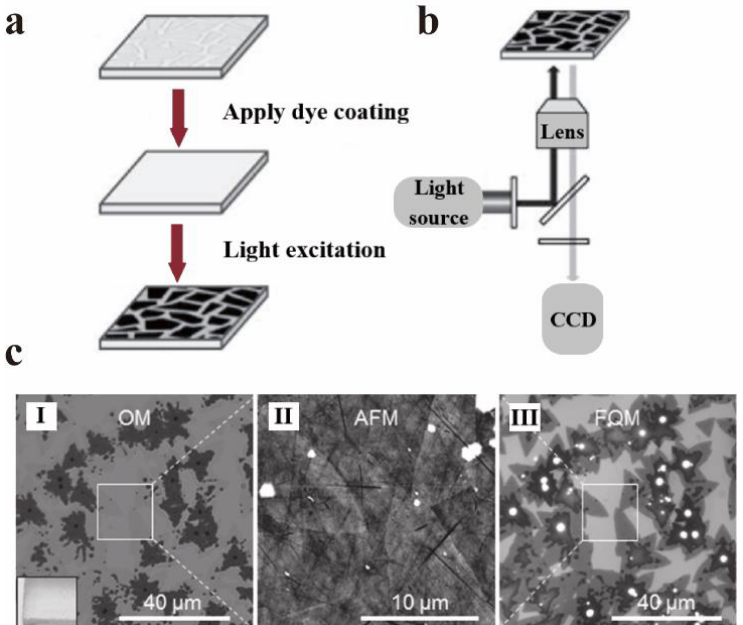
Figure 19. High throughput visualization of graphene substrate by FQM: ( a ) schematic diagram of fluorescent dye layer covering on GO substrate. ( b ) The schematic diagram of the substrate for the imaging of the lower sheet when excited. Reprinted with permission from [112]. Copyright 2014, Elsevier. ( c ) Comparison of images of OM (I), AFM (II), and FQM (III) using MoS 2 as an example. Reprinted with permission from [113]. Copyright 2013, John Wiley and Sons.